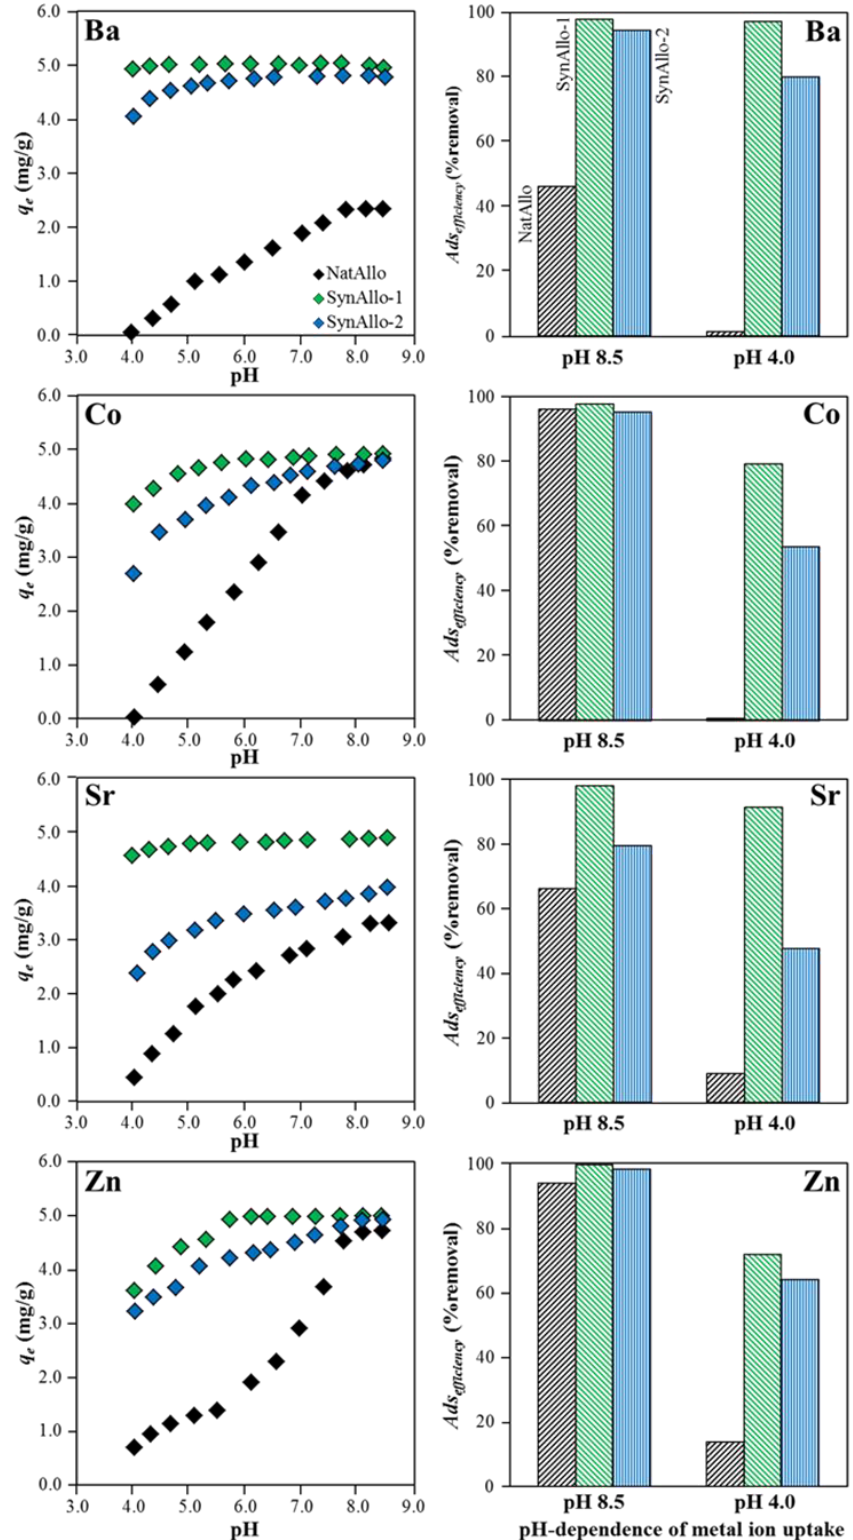
Figure 5. Adsorption of aqueous Ba, Co, Sr, and Zn by natural and synthetic allophanes as a function of pH ( left panel ). Effect of pH on the adsorption behavior of aqueous metal ions ( right panel ). Adsorption efficiencies at pH 8.5 versus pH 4.0.